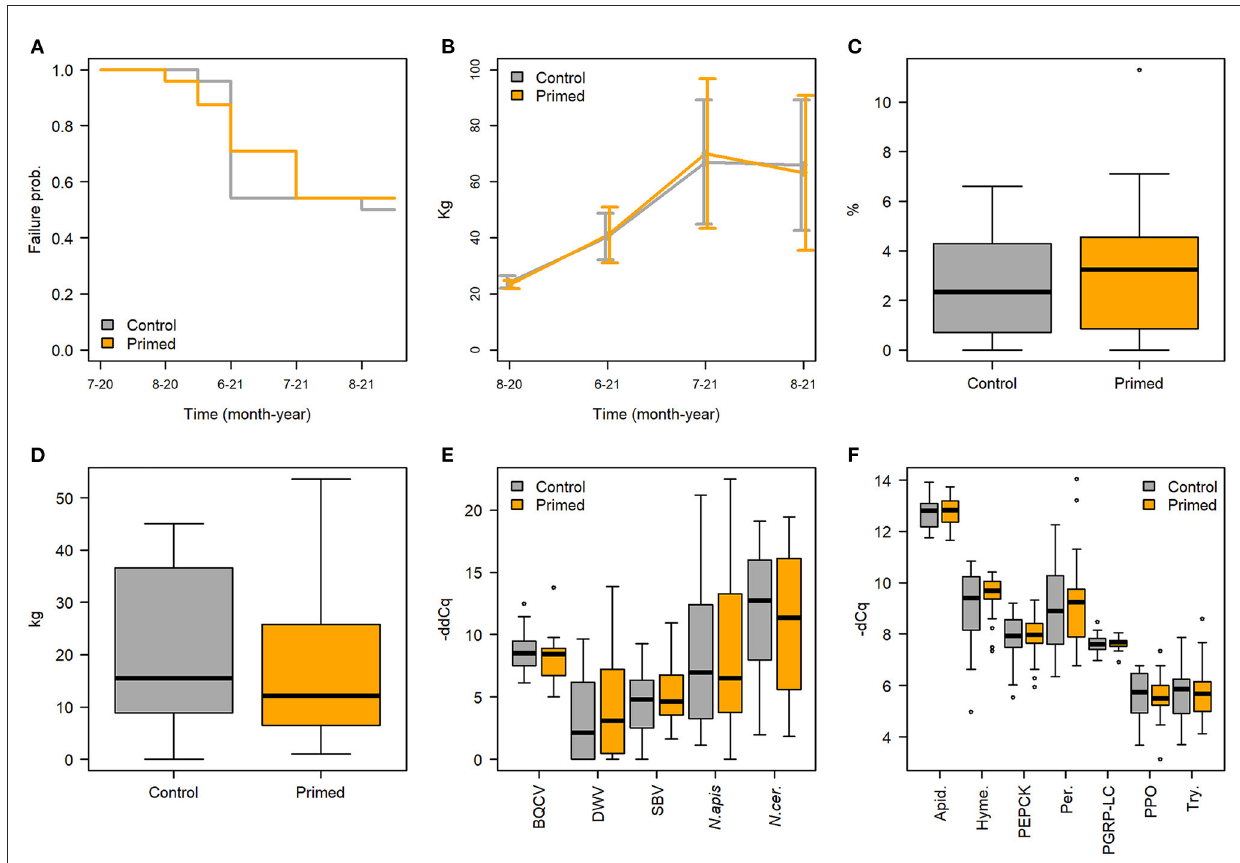
FIGURE3 No effect of priming was detected to hive performance and health in regard to (A) hive failures, (B) median hive weight ( + -sd), (C) percentage of brood on frames before winter, (D) overall honey yield, (E) pathogen -ddCq in August 2020, (F) gene expression -dCq in August 2020. Primed hives shown in orange and controls in gray.